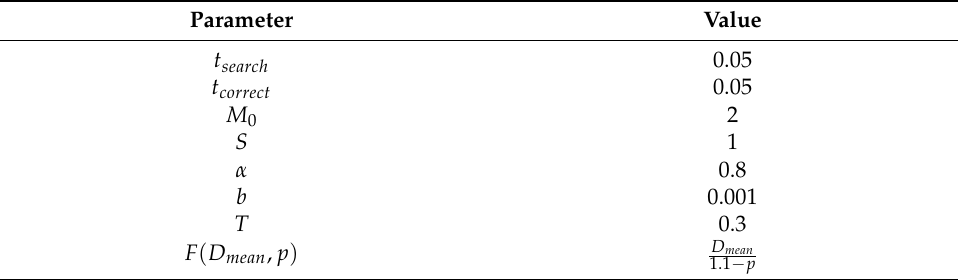
Table 2. Parameters of PAA used in the experiments.